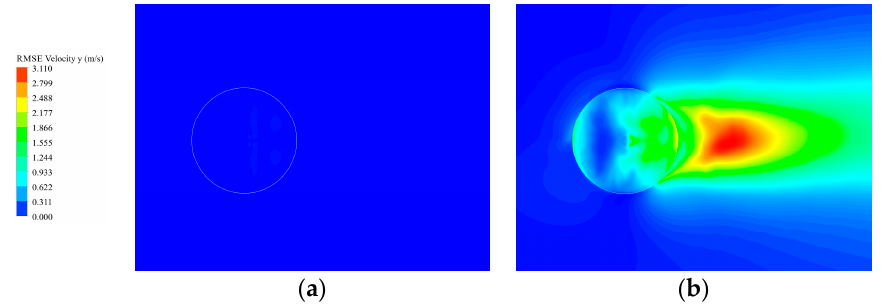
Figure 26. Comparisons of the root mean square error v at horizontal plane (z = 85 m) of the cooling tower: ( a ) URANS and ( b ) LES.